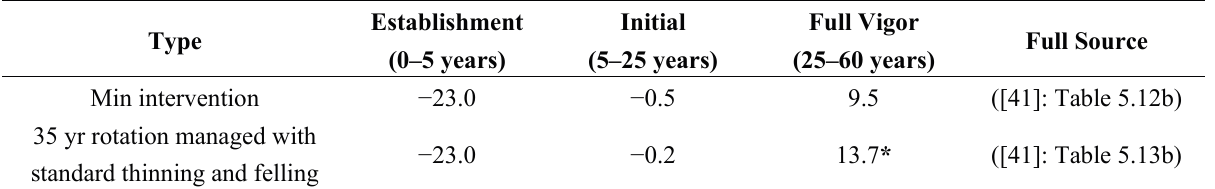
Table 2. Carbon stock change factors data (in t·CO stands with (i) minimum intervention; and (ii) 35 year rotation with standard thinning and felling due to a land use change from grassland to forestry.